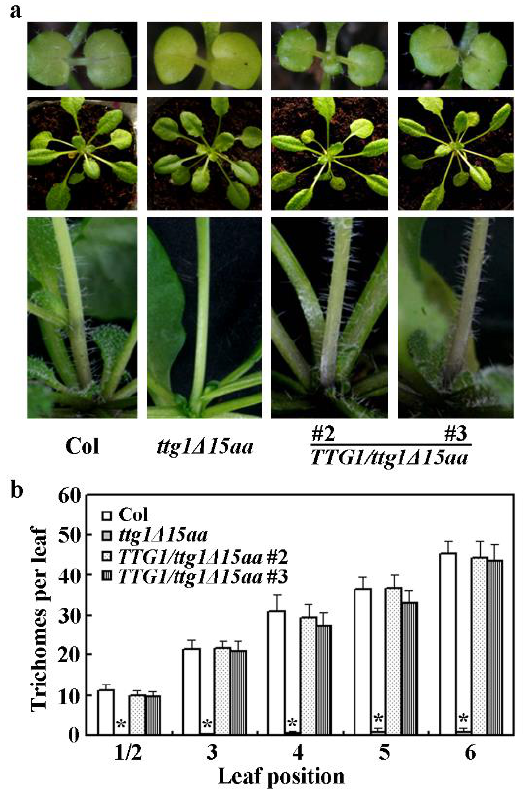
Figure 3. Expression of TTG1 under the control of its native promoter restores trichome formation in the ttg1 ∆ 15aa mutant. ( a ) Trichome formation on leaves of 10-day-old seedlings (up panel), 4-week- old plants (middle panel), and stems of 5-week-old plants (lower panel) of the Col wild type, the ttg1 ∆ 15aa mutant, and the TTG1/ttg1 ∆ 15aa transgenic plants. Seeds of Col wild type, the ttg1 ∆ 15aa mutant, and the TTG1/ttg1 ∆ 15aa transgenic plants were germinated and grown in soil pots. Pictures were taken directly or under a Motic K microscope by using an EOS 1100D digital camera at indicated stages. ( b ) Trichome numbers on the first two, third, fourth, fifth and sixth rosette leaves of the Col wild type, the ttg1 ∆ 15aa mutant, and the TTG1/ttg1 ∆ 15aa transgenic plants. Trichome numbers on the indicated leaves were count under a Motic K microscope. Date represence mean ± SD of 10–14 leaves. *, Significantly different from that in the Col wild type (student’s t test, p < 0.0001).